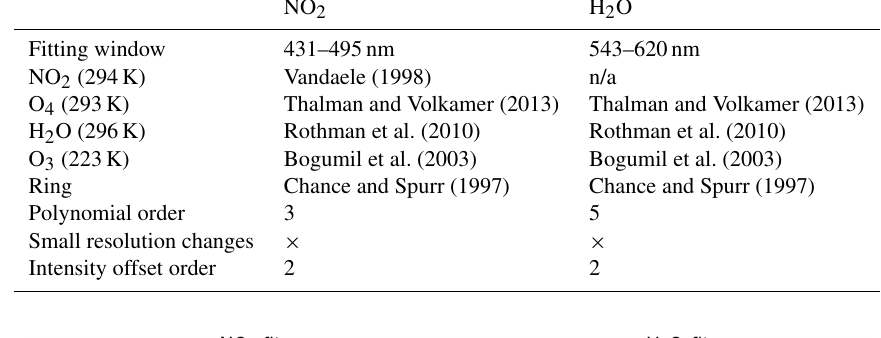
Table 2. DOAS analysis settings for the NO 2 and H 2 O fits.